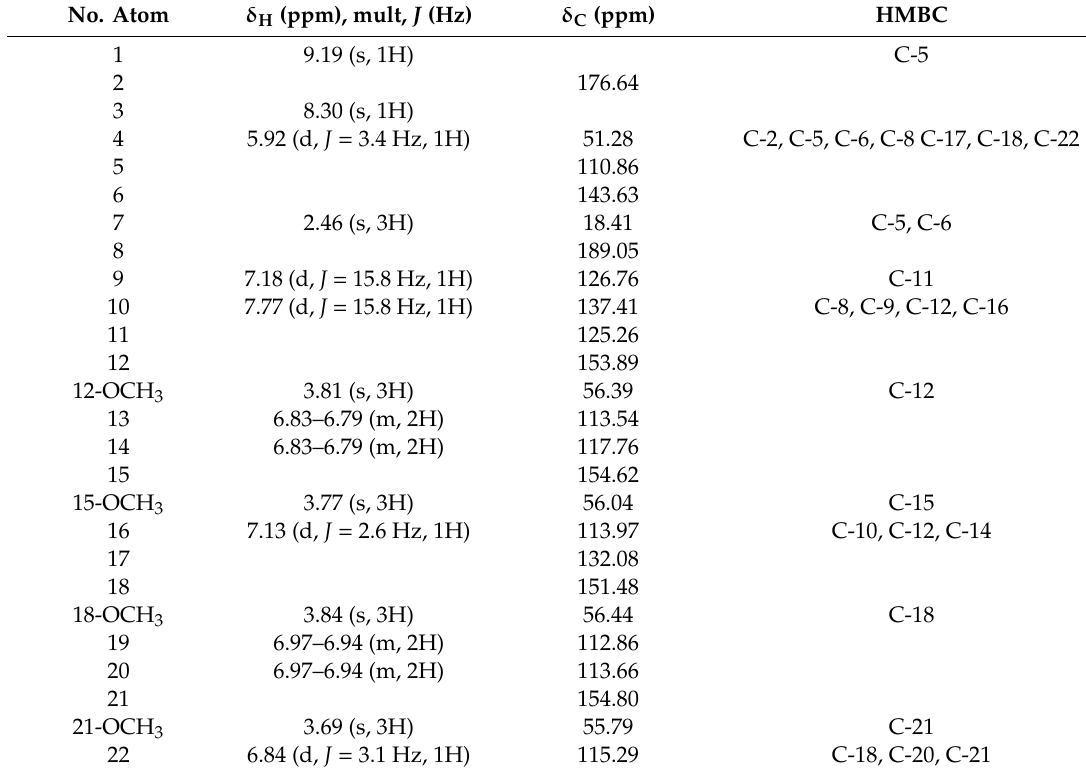
Table 2. NMR data of compound 5 in Acetone- d 6